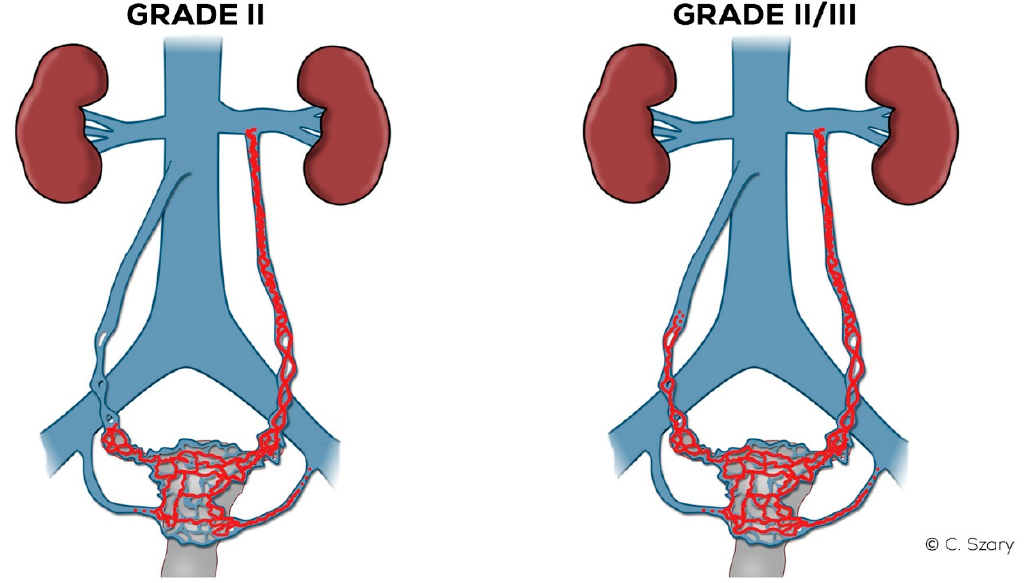
Figure 11. Schematic illustration of ovarian veins insufficiency: Grade II (GII) and Grade II/III (GII/III).